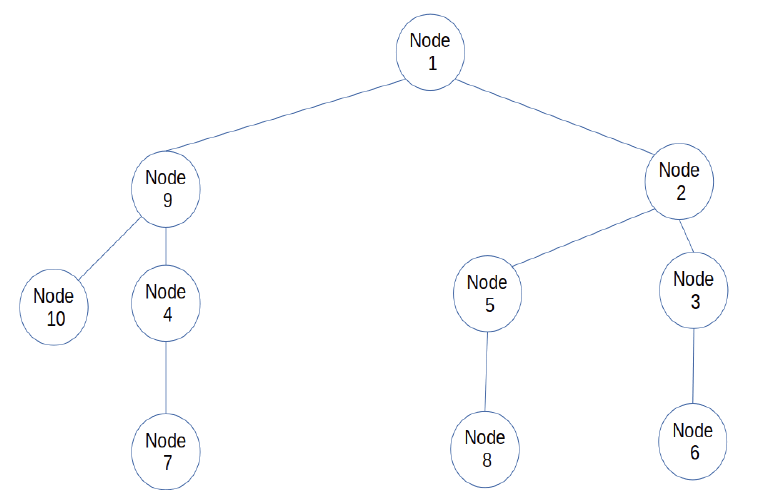
Figure 5. Mono sink sensor network.